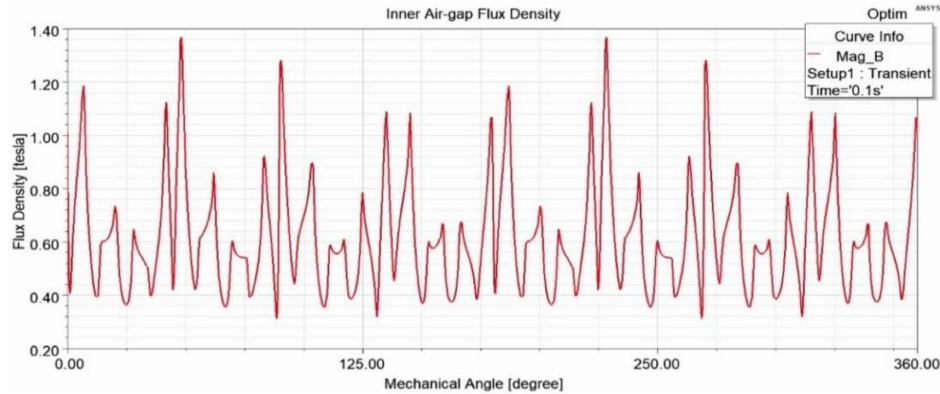
Figure 10. Inner air-gap flux density.